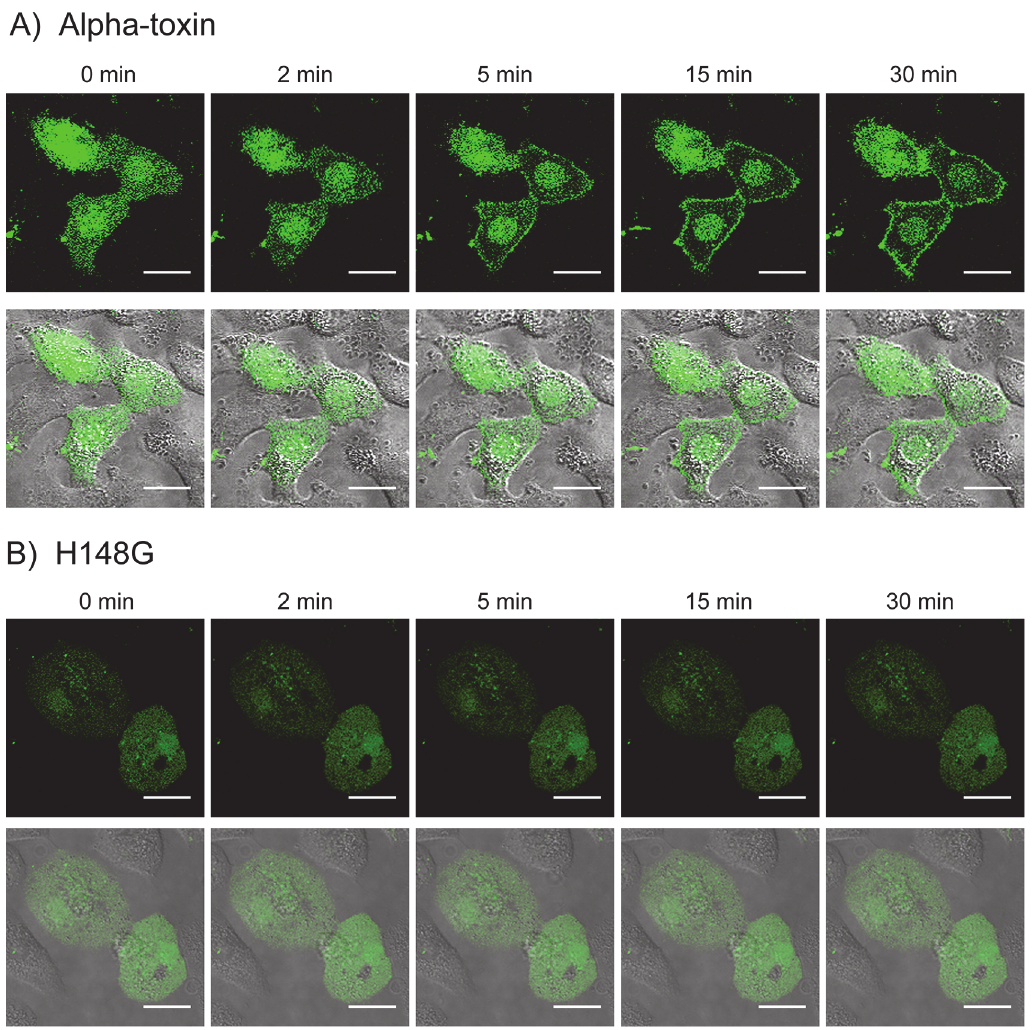
Fig 1. Transbilayer movement of DAG on the membrane treated with alpha-toxin. DNA transfection was used to express EYFP-C1AB in A549 cells. After 24 h, cells were incubated with 1.0 μ g/mL wild-type alpha-toxin (A) or H148G alpha-toxin (B) at 37°C. The cells were visualized by confocal fluorescence microscopy. Scale bar, 10 μ